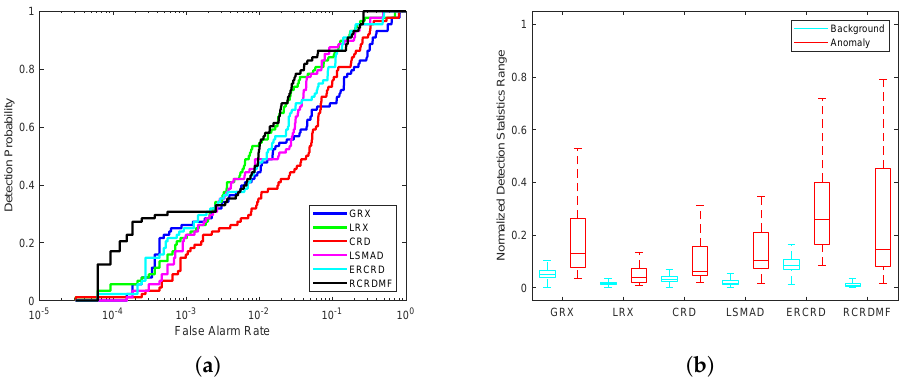
Figure 16. Detection accuracy evaluation for the Salinas dataset. ( a ) ROC curves. ( b ) Normalized background-anomaly separation